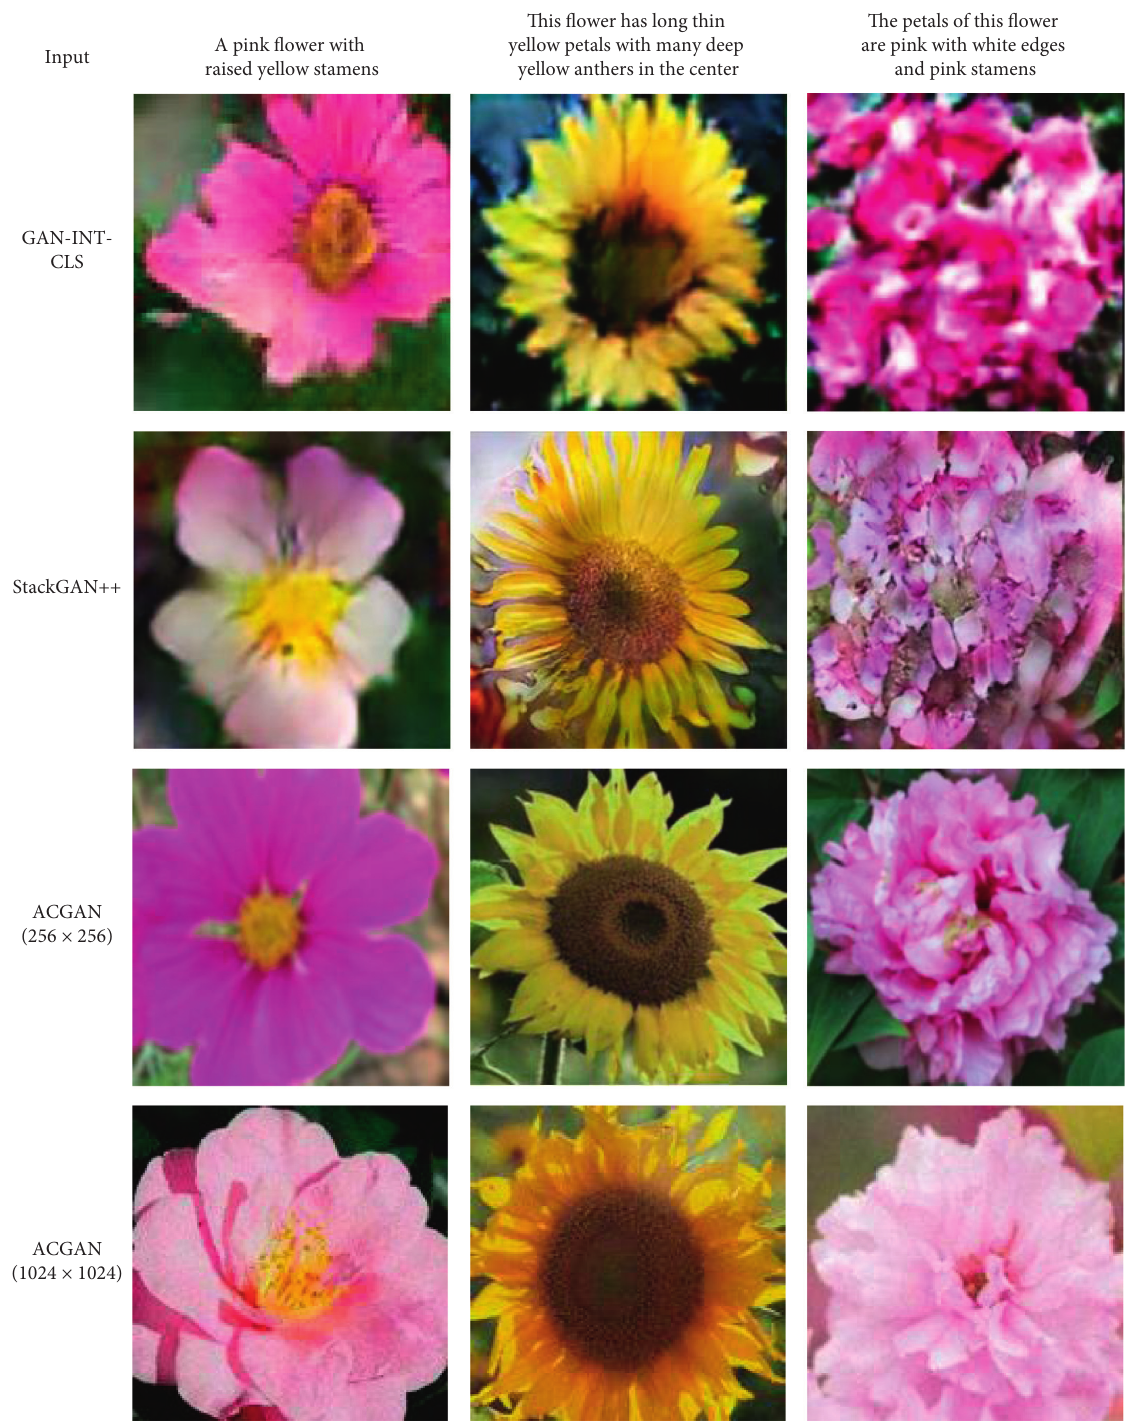
Figure 5: Images generated from descriptions using three GAN models trained on Oxford test